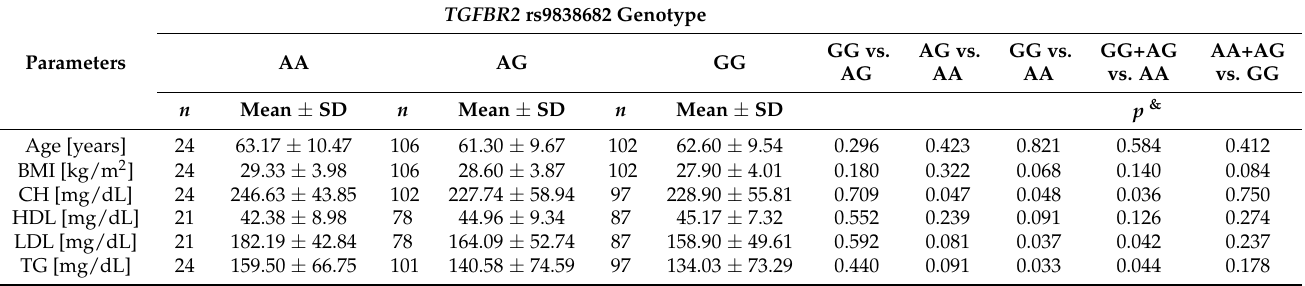
Table 8. Associations between the clinical parameters of patients with unstable angina and the TGFBR2 rs9838682